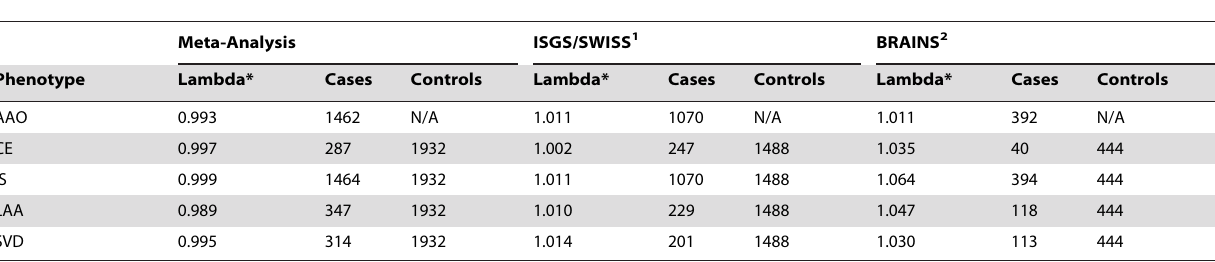
Table 2. Descriptive information for GWAS